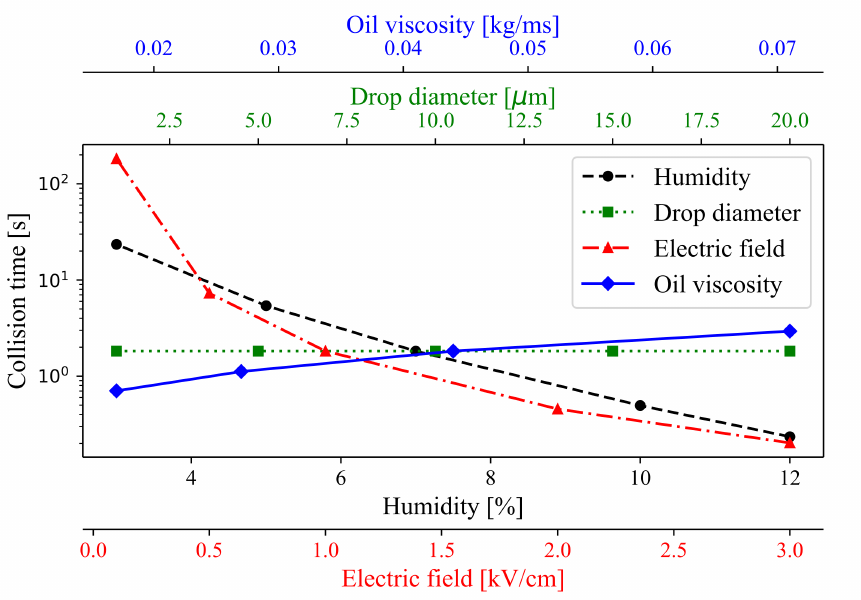
Figure 5. Collision time as a function of the main process variables explored in this study: water content, droplet diameter, electric field intensity, oil